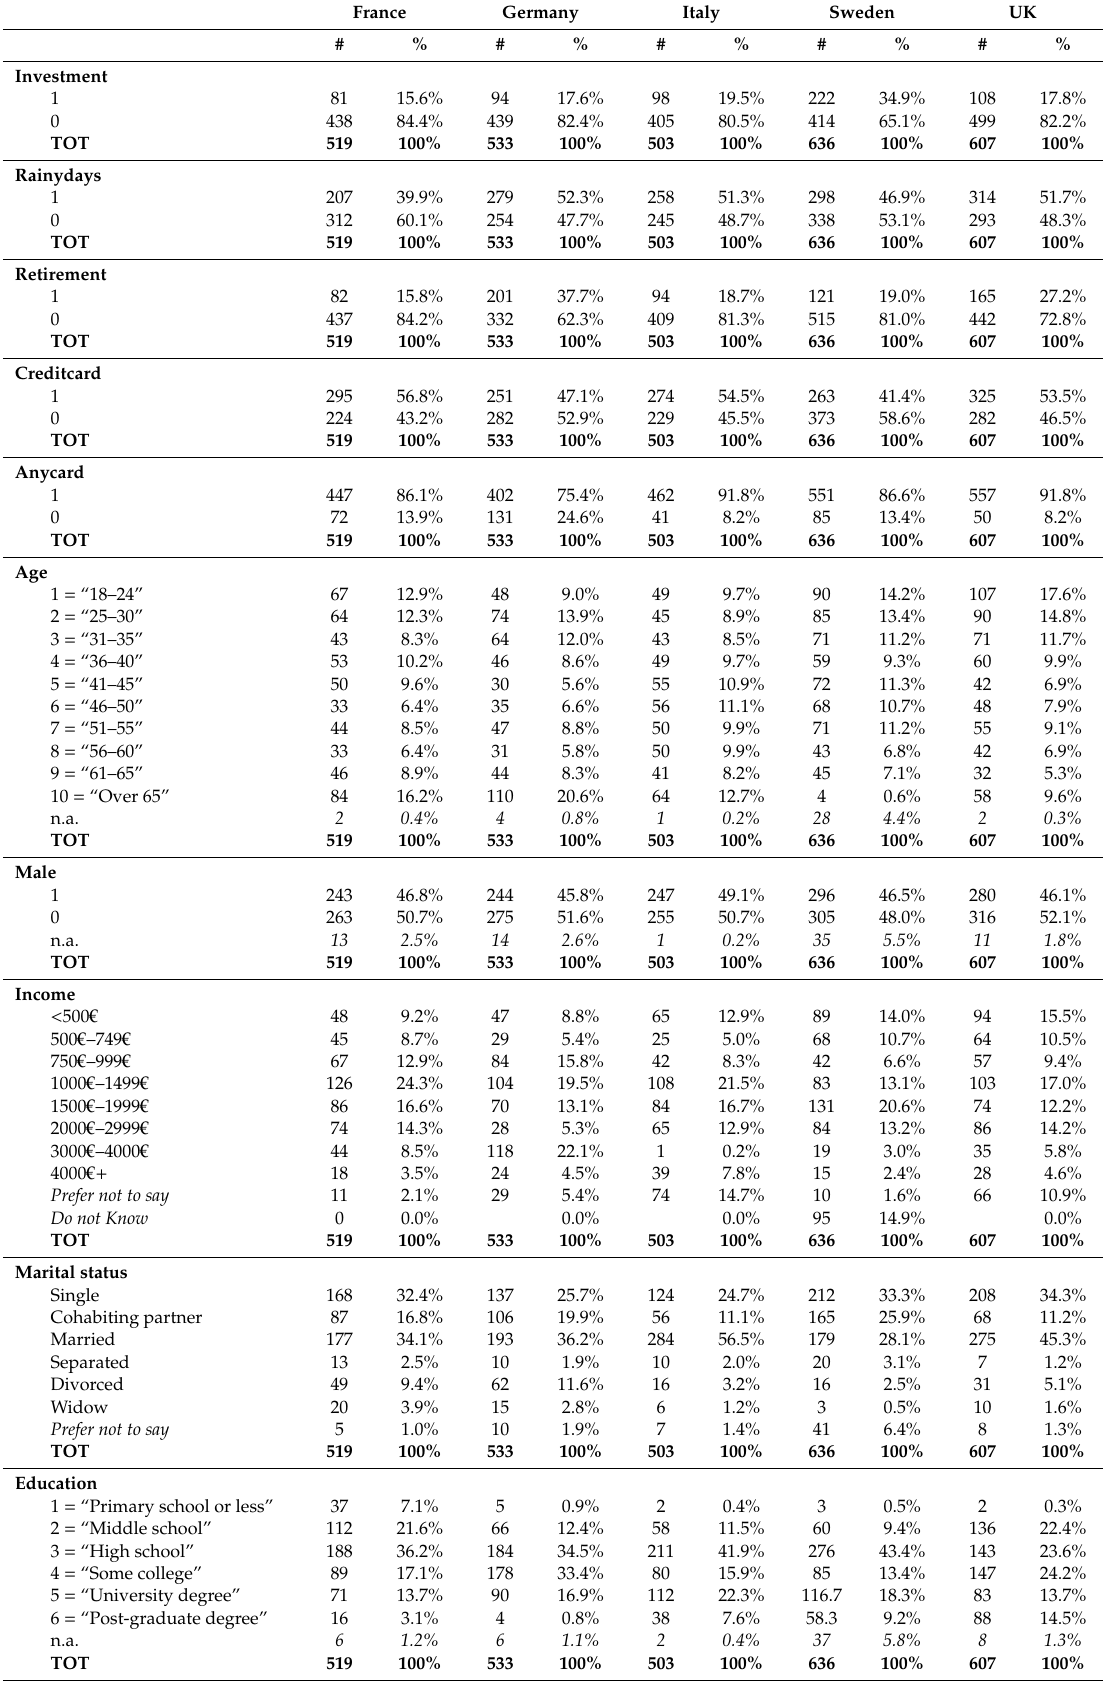
Table A2. Descriptive statistics of the dependent and independent